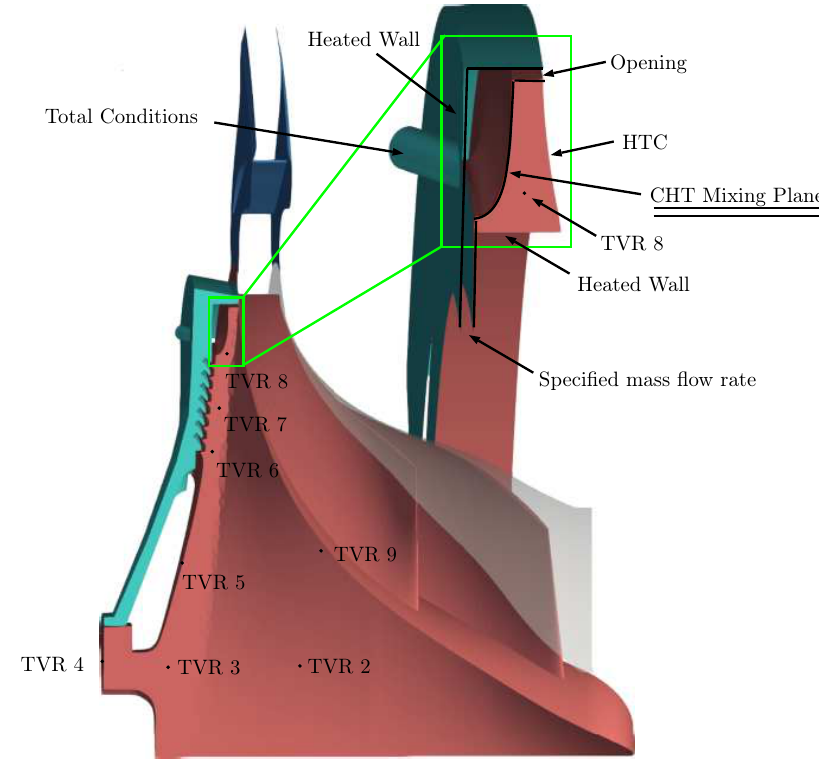
Figure 6. Reduced domain with boundary conditions.